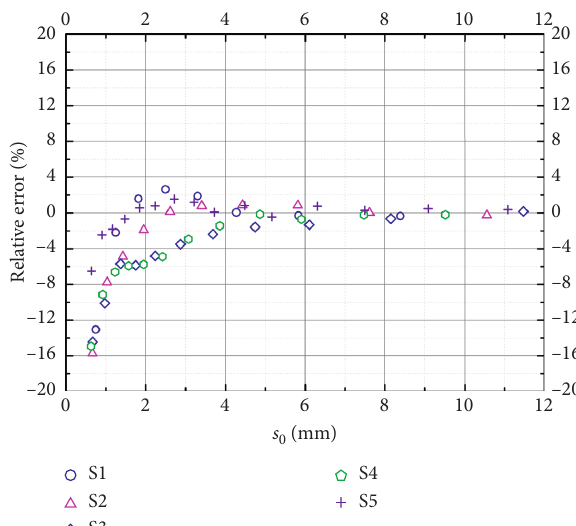
Figure 9: Error analysis of the theoretical and measured value.